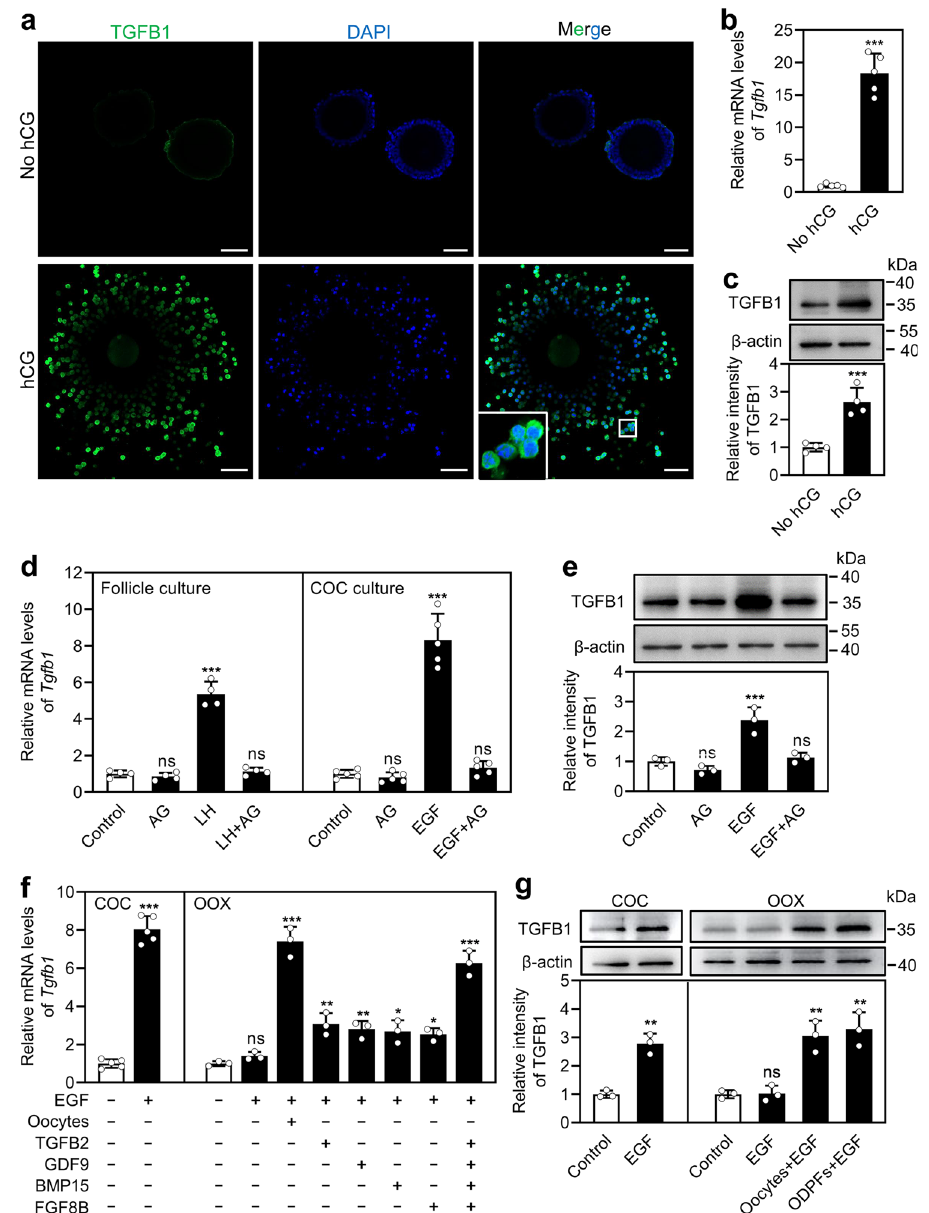
Fig. 1 LH/hCG promotes TGFB1 expression in cumulus cells. Large follicles and COCs were isolated from eCG-primed mice. OOX cumulus cells were produced by microsurgically removing oocytes from the COCs. OCCs were collected from the ampullae of superovulated mice (at 13 h post-hCG treatment). a Immuno fl uorescence analysis of TGFB1 (green) in cumulus cells before and after hCG injection (at 13 h post-hCG treatment). ( n = 3 independent experiments). Nuclei were counterstained by DAPI (blue). The small white box indicates the location of the enlarged area, as shown in the lower left corner. Scale bars represent 50 μ m. b , c Comparison of steady-state mRNA ( b ) and protein ( c ) levels of TGFB1 in cumulus cells before and after hCG injection (at 13 h post-hCG treatment). ( n = 5 independent experiments in ( b ) and n = 4 independent experiments in ( c )). d , e The effects of LH and EGF on TGFB1 mRNA ( d ) and/or protein ( e ) expression in cumulus cells. Follicles were cultured in medium supplemented with LH (1 μ g/ml) and/or AG1478 (1 μ M) for 12 h, and COCs were cultured in medium supplemented with EGF (10 ng/ml) and/or AG1478 for 12 h. ( n = 3 – 5 independent experiments). f , g The effects of EGF, oocytes, and ODPFs on TGFB1 mRNA ( f ) and protein ( g ) expression in cumulus cells. COCs or OOX cumulus cells were cultured in a medium supplemented with EGF, oocytes (3 oocytes/ μ l), GDF9 (500 ng/ml), BMP15 (500 ng/ml), FGF8B (FGF8, 100 ng/ml), and/or TGFB2 (50 ng/ml) for 12 h. ODPFs, GDF9 + BMP15 + FGF8B + TGFB2; AG, AG1478. ( n = 3 – 5 independent experiments). β -actin was used as a loading control in ( c ), ( e ), and ( g ). Bars indicate the mean ± SD. Each data point represents a biologically independent experiment. Statistical analysis was performed by two-tailed unpaired Student ’ s t -test for two groups, and by one-way ANONA Tukey test for experiments involving more than two groups. ns, no signi fi cance ( P ≥ 0.05). * P < 0.05, ** P < 0.01, and *** P < 0.001.